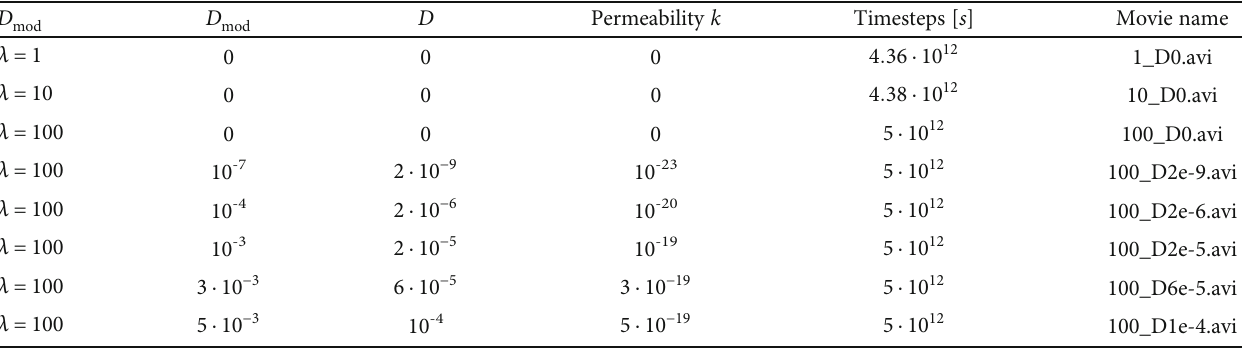
Table 2: Simulation parameters and movie names (in the supplementary material (available here)). Values of D are used for all fi gures and are the equivalents in